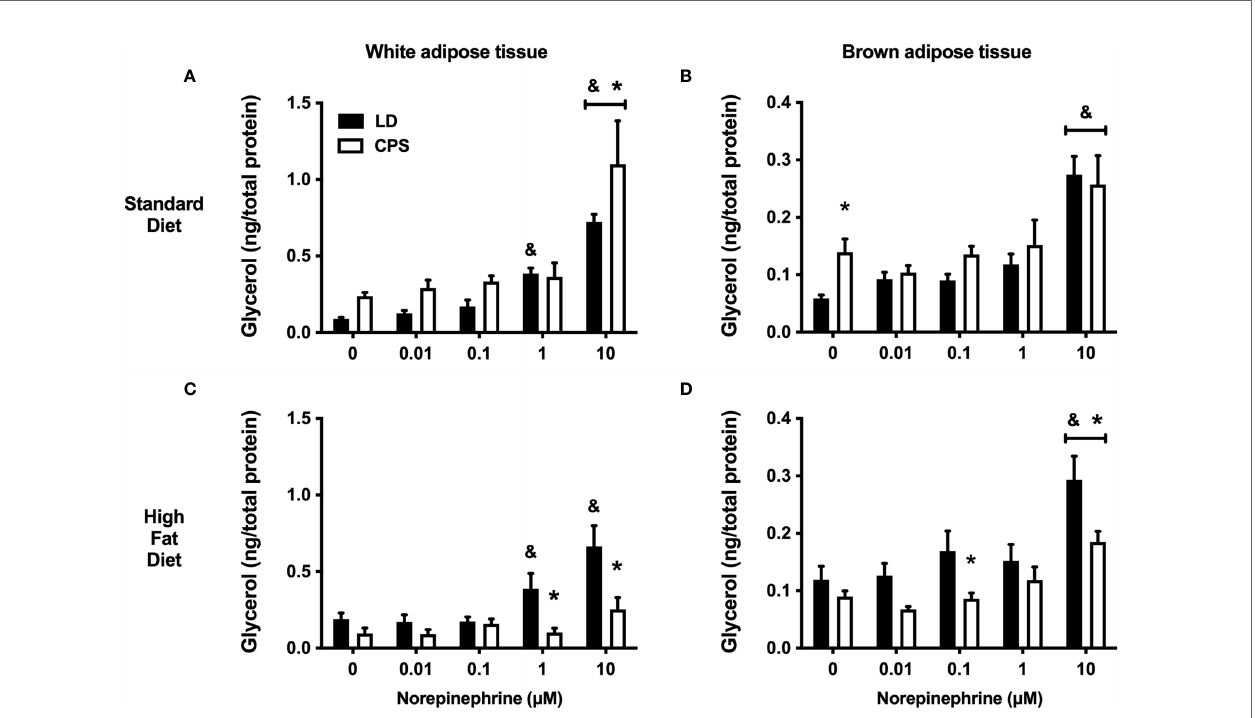
FIGURE 7 | Effects of gestational chronic phase shift of photoperiod on glycerol response to increasing doses of norepinephrine (NE) of white epigonadal adipose tissue (A, C) and brown interscapular adipose tissue (B, D) . Explants from 200-day-old rats fed with either standard diet Prolab ® RMH 3000 (A, B) or 45% high-fat diet (HFD; C, D). Data are mean±SEM. Black bars: LD, adult rats that had been gestated under control 12:12 (LD) photoperiod. White bars: CPS, adult rats that had been gestated under chronic phase shift (CPS) photoperiod. n = 8 per group. *different from LD. & Different from basal LD (0 m M NE). All comparisons: p < 0.05 pairwise comparison at each time point with Bonferroni